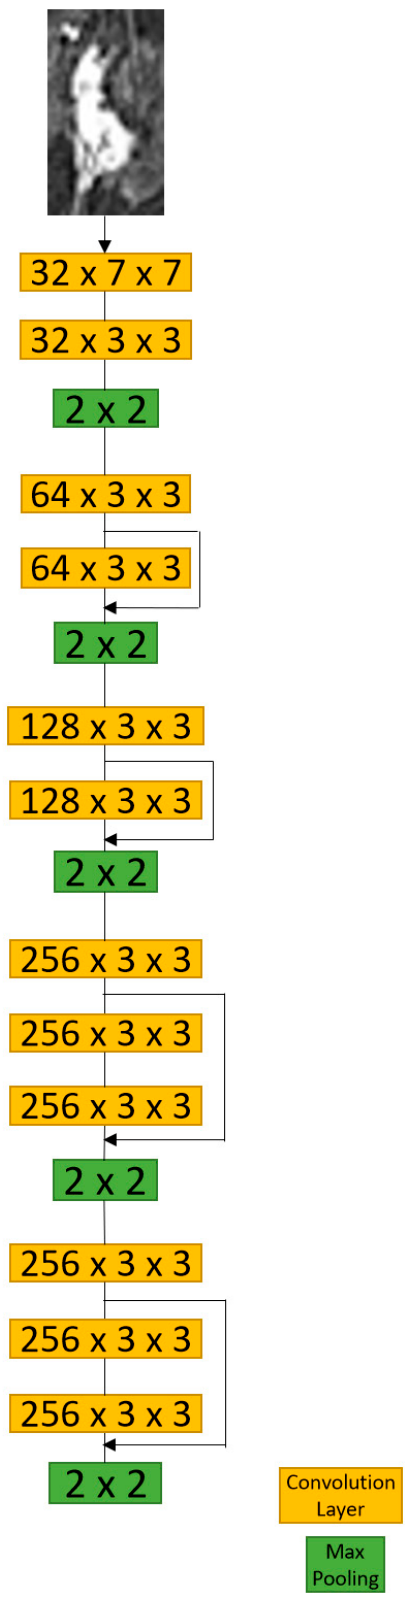
Figure 5. Diagram of Convolutional Neural Network (CNN) with ROIs model. Note that the archi- tectures of the convolution blocks in Recurrent Residual Convolutional Neural Network (RRCNN) are similar to those in this